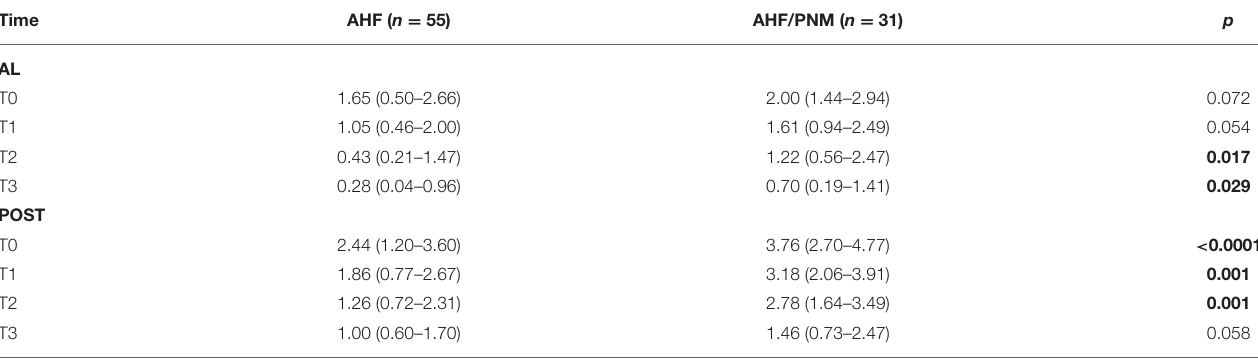
TABLE 2 | Difference in AL and POST B-lines score between AHF and AHF/PNM at each time point.